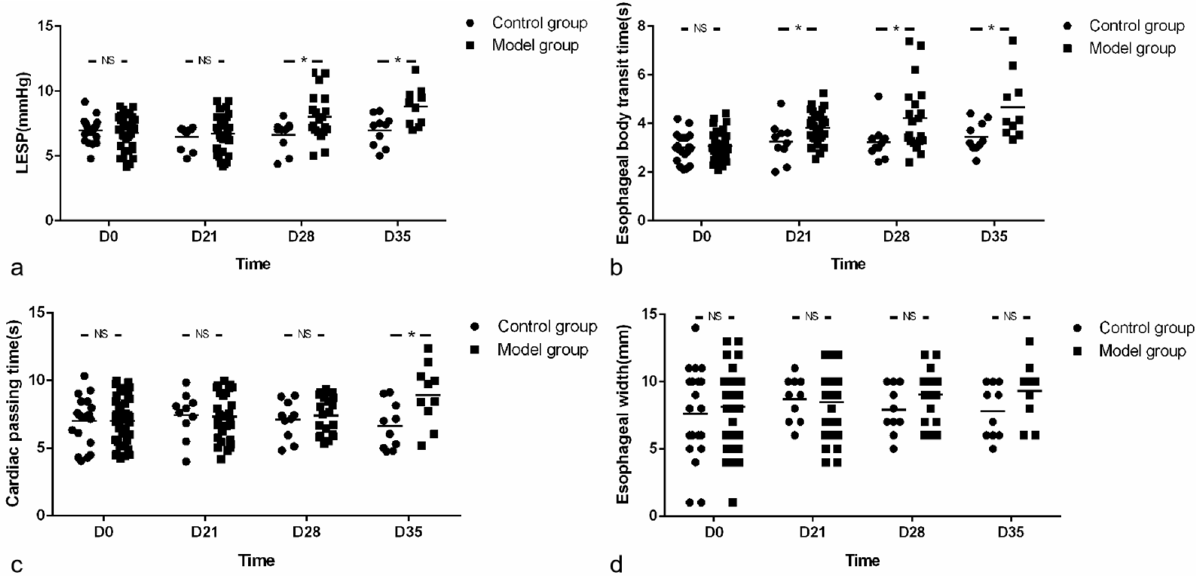
Figure 5. The LESP during baseline and different time points, esophageal emptying test and esophageal radiography. ( a ) Although there was no difference between model group and control group at baseline, the LESP was higher at D28 and D35. ( b ) During OVA treatment, the esophageal body transit time of mice in model group was longer than that of control group at D21, D28 and D35, respectively. ( c ) Although there was no difference between groups at baseline, the cardiac passing time of model group was longer than that of control group at the end of the experiment. ( d ) At every time point, there was no significant difference in the esophageal width between groups. The number of mice in control group was 20, 10, 10 and 10, for each time point (D0-D35). In contrast, the number of mice in model group was 40, 30, 20 and10 for each time point, respectively. Unpaired t -tests were used in comparison between groups and among different viewpoints in model group. LESP: lower esophageal sphincter pressure. * p < 0.05, NS—not